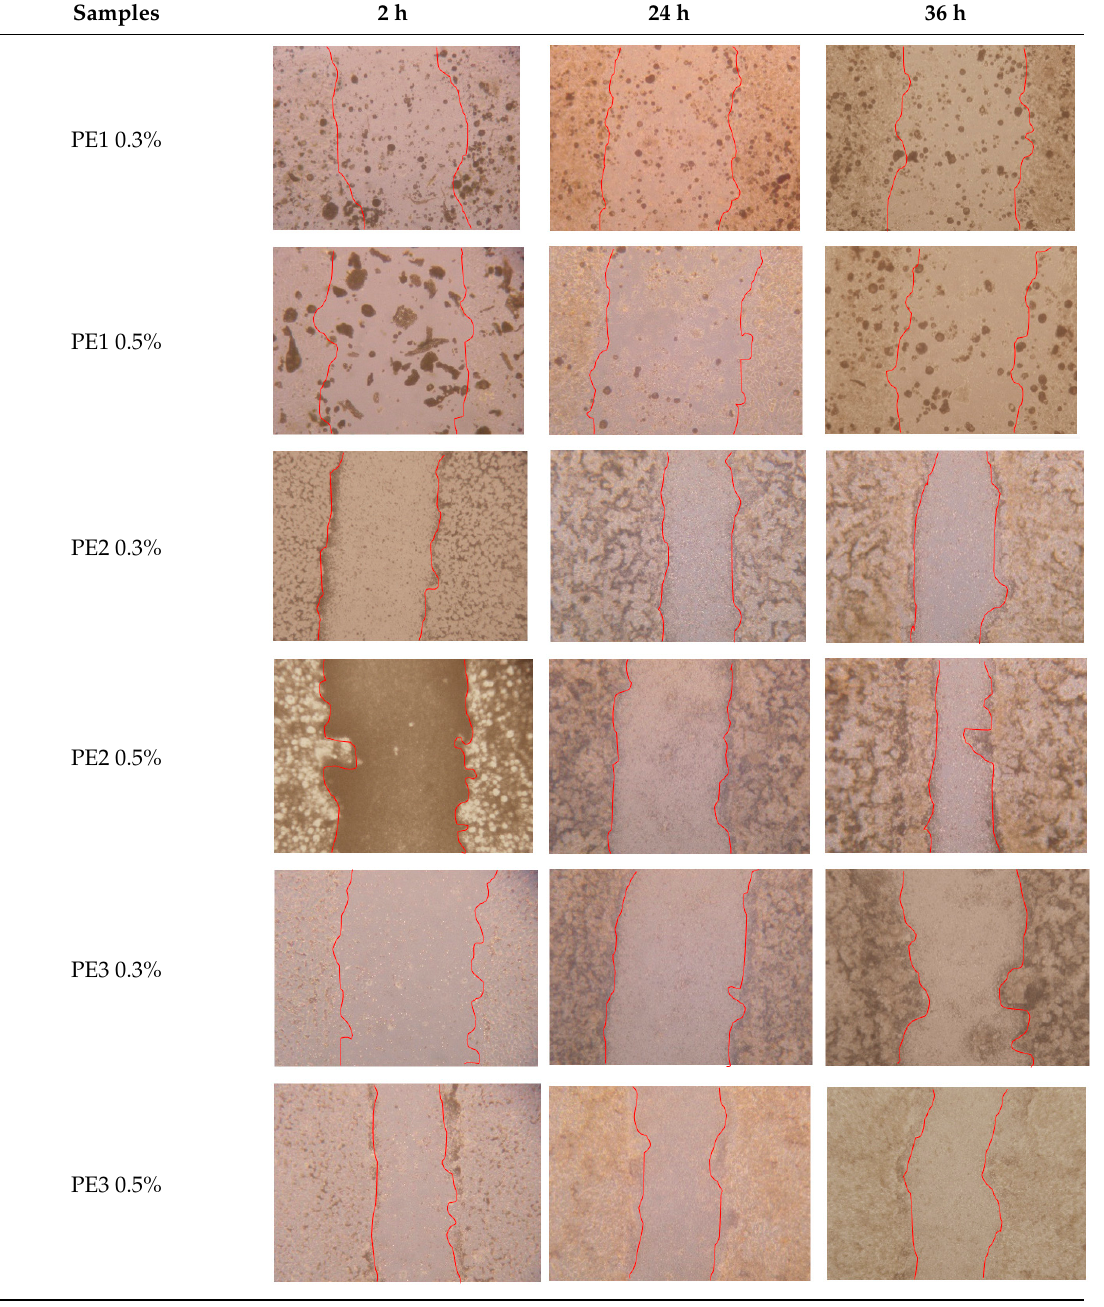
Table 5. Microscopic images obtained from the scratch wound-healing assay with the mixtures of honey with propolis (magnification: 100×).